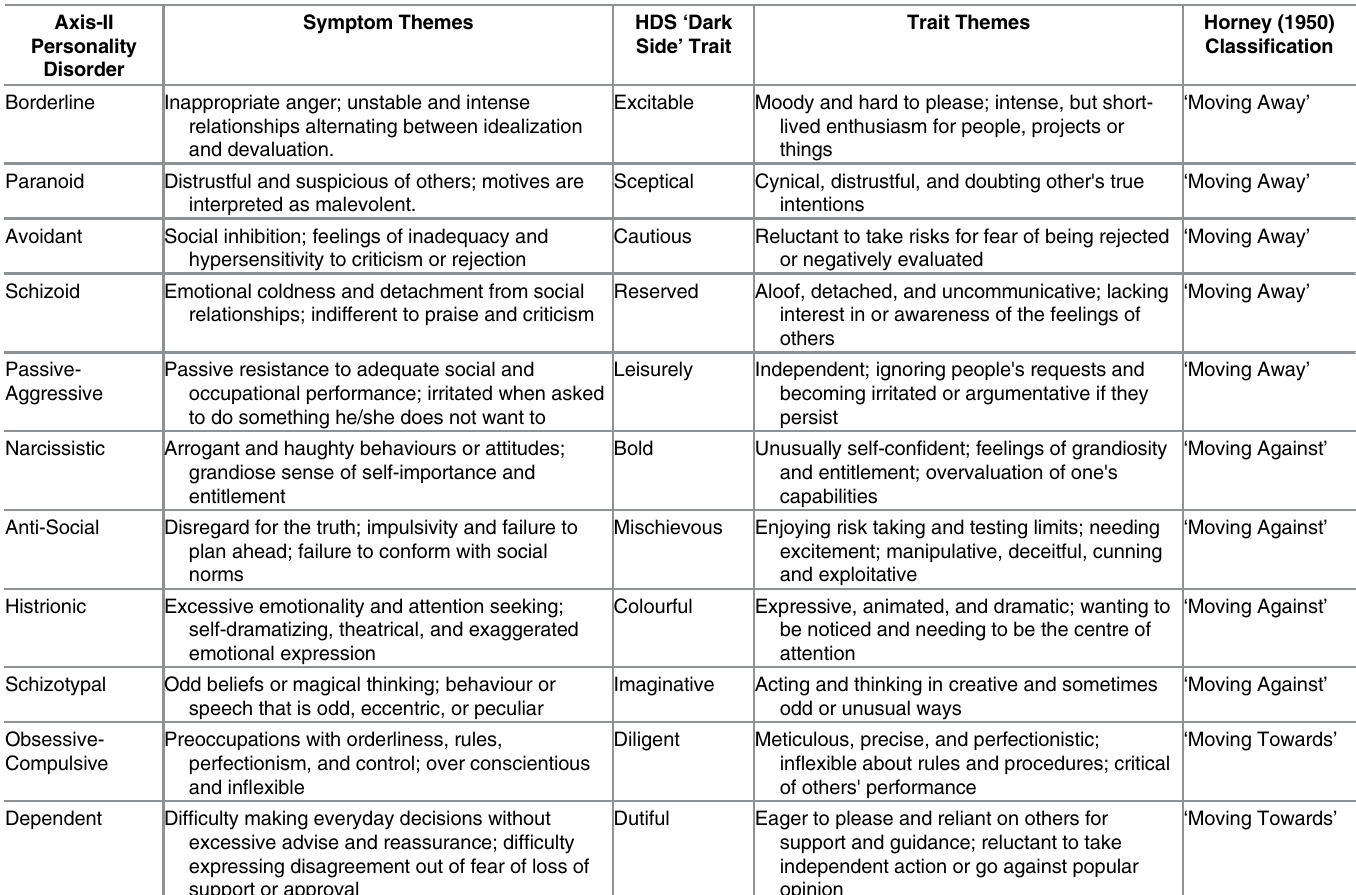
Table 1. Comparison in Themes Between DSM-IV-R Axis-II Personality Disorders and HDS ‘ Dark Side ’ Traits. Axis-II